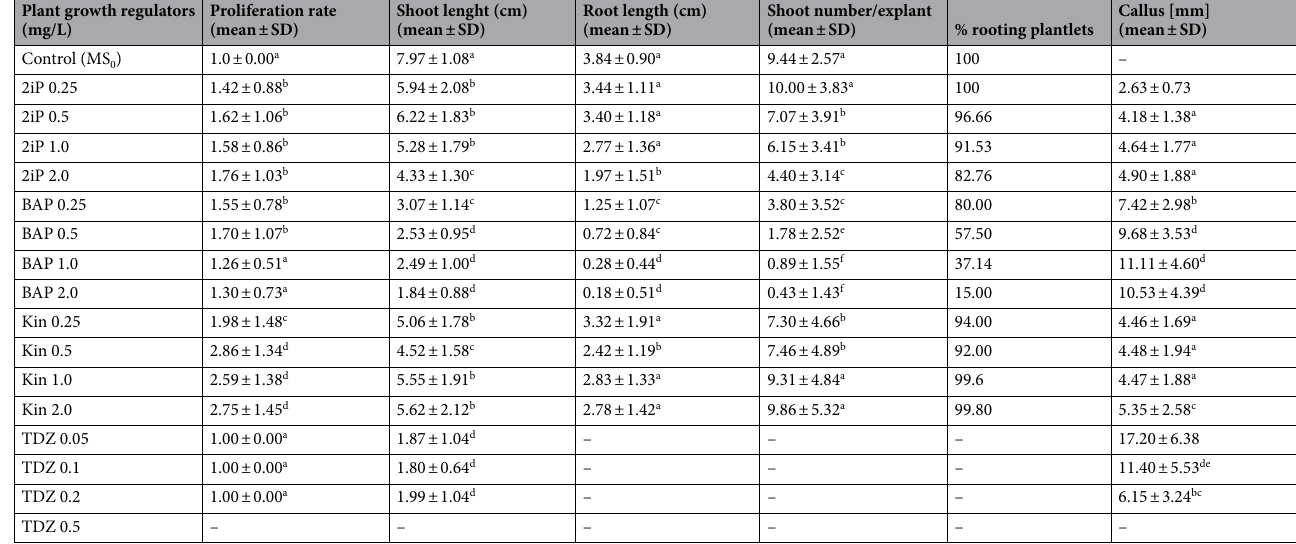
Table 4. Effects of single cytokinins on the growth and proliferation of P. amarus shoot culture. The results are the arithmetic means of ≥ 50 trials ± SD. The values in each column marked with different letters (a, b, c…) indicate statistically significant differences (p < 0.05; Tukey’s RIR test).